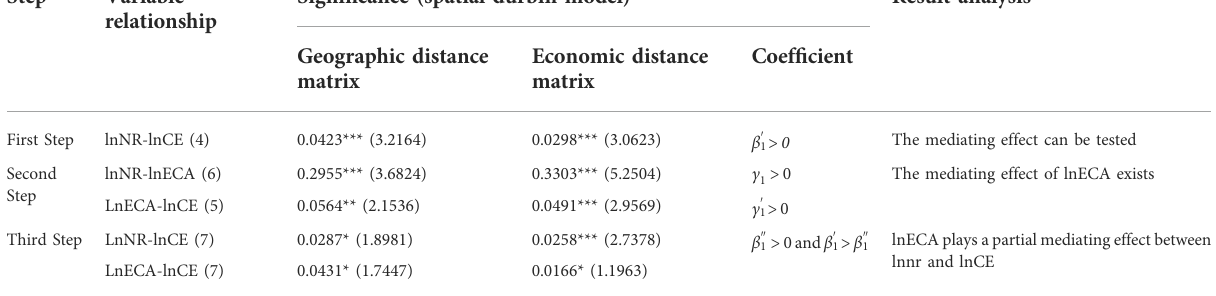
TABLE 8 Analysis of mediating